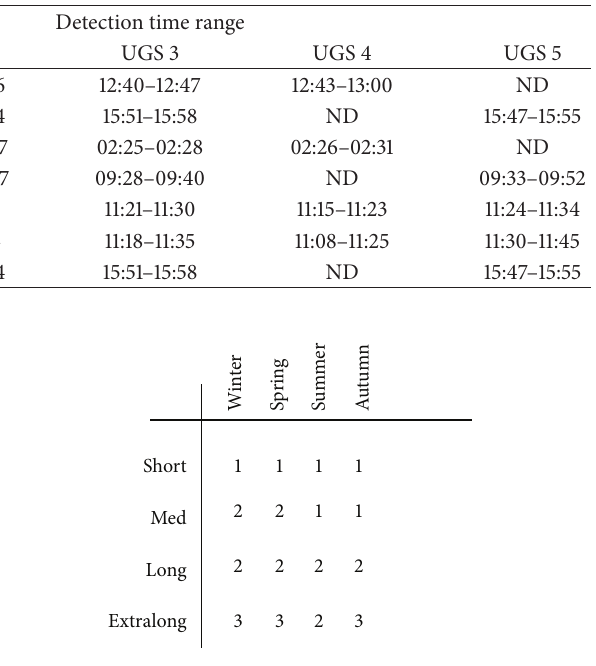
Figure 17: Inference engine based upon season and time since maintenance.